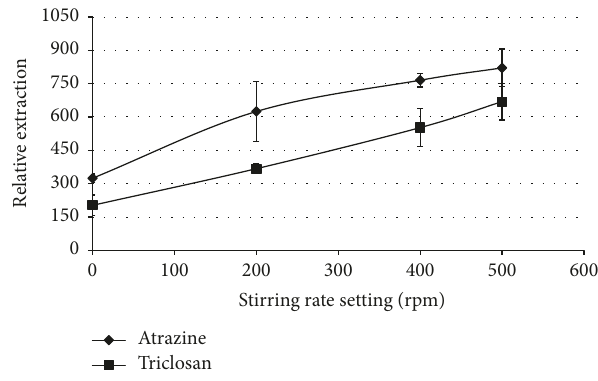
Figure 5: Effect of stirring the aqueous solution on the extraction of the analytes . Conditions: volume, 1mL of 5 𝜇 g/mL atrazine and triclosan aqueous sample to which 15mg NaCl was added (15% w/v); 25 𝜇 L of a 1: 4 (v/v) chlorobenzene : ethyl acetate mixture with the extraction time of 20 minutes and with toluene as the acceptor